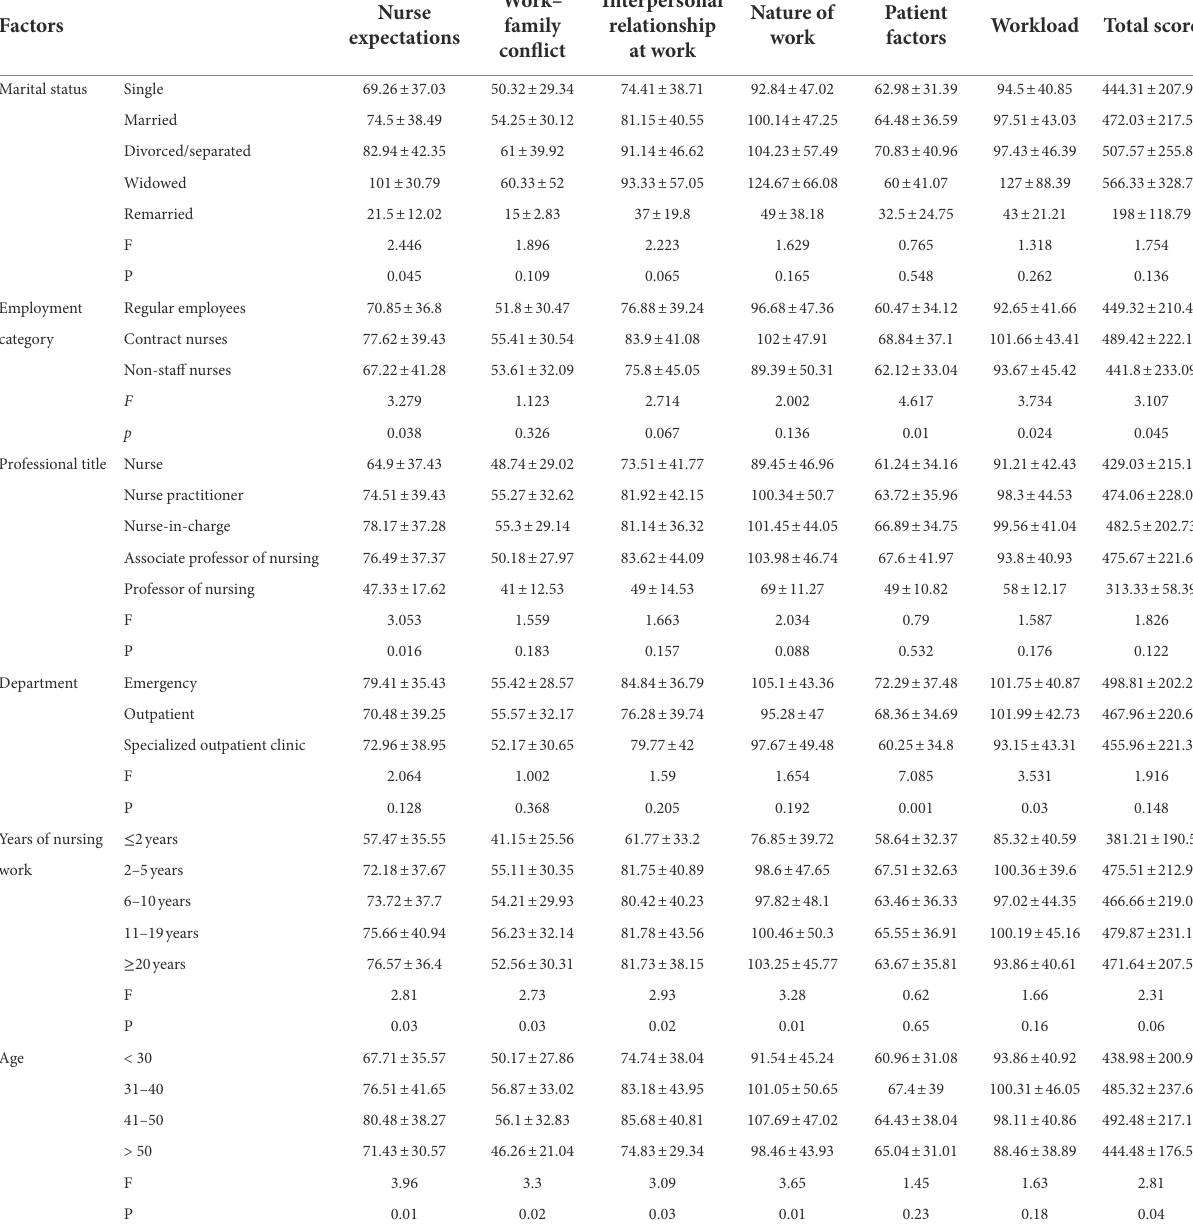
TABLE 3 Univariate analysis of the different general information on work stressors of pediatric outpatient and emergency nurses ( n = 1,457).